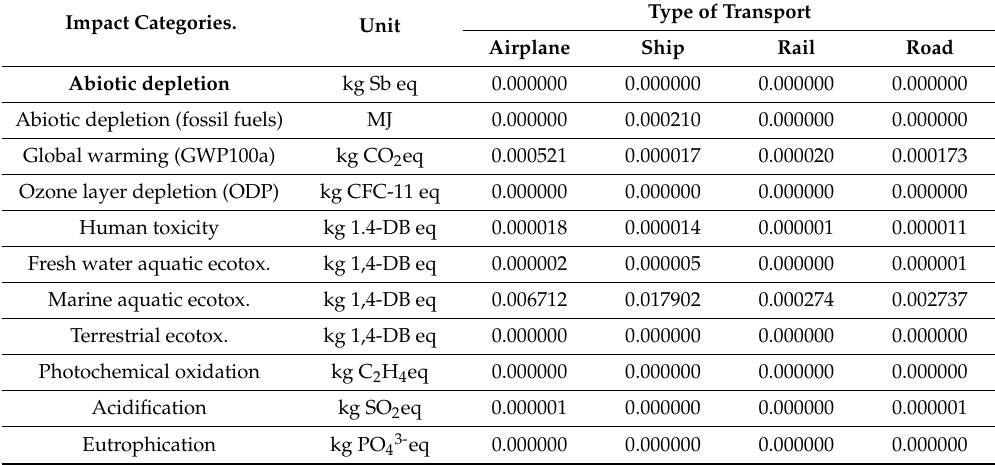
Table 11. LCA results by type of transport used. Values per km per liter of olive oil transported. Impact